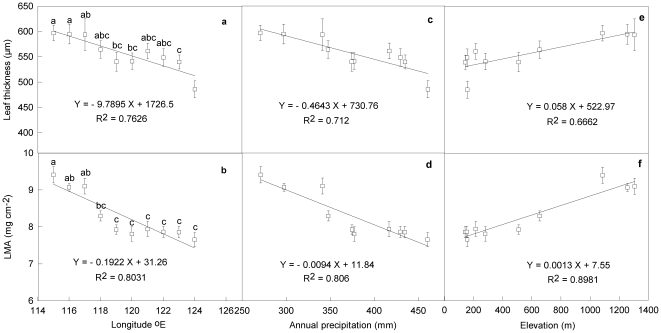
Variations of leaf thickness (a) and leaf mass per unit area (LMA) (b) in Leymus chinensis along large-scale longitudinal gradient and their correlations with annual precipitation (c, d) and elevation (e, f) at the gradient in northeast China.Bars are means (± SE) of 25–30 replications. Bars with the same lowercase letters indicate no statistically significant differences (P > 0.05).